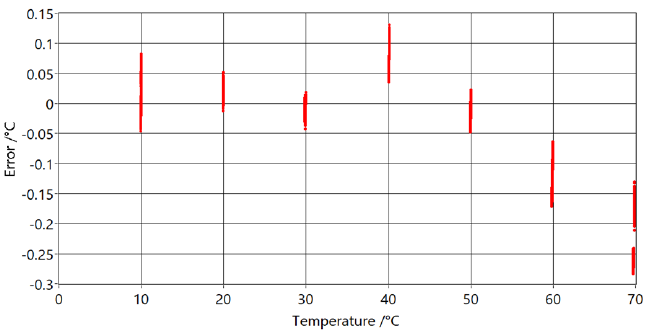
Figure 21. Temperature error versus reference temperature readings with used ASC algorithm.